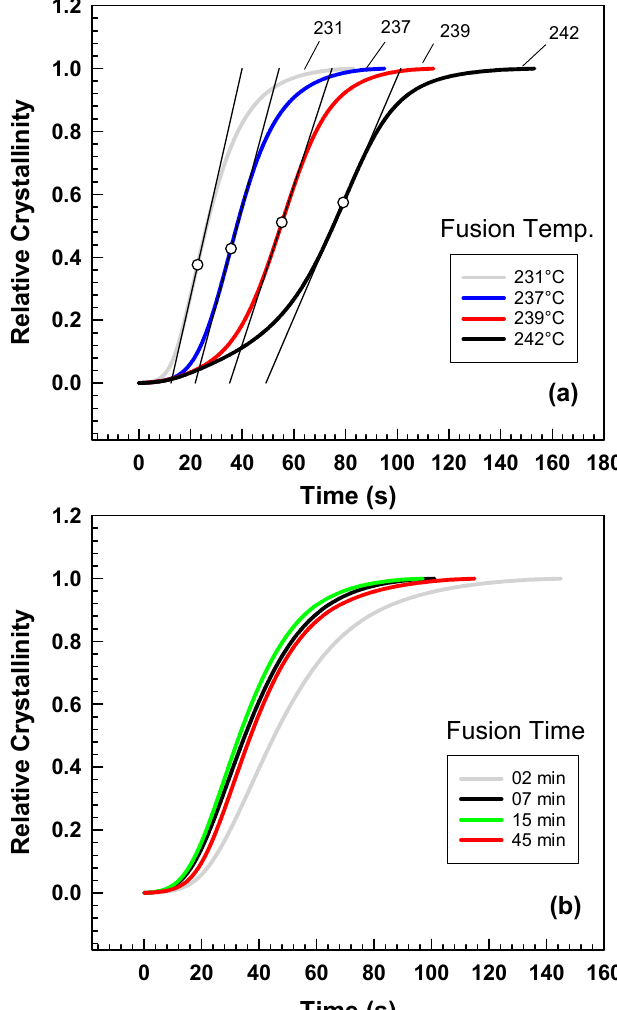
Figure 4. Crystallization kinetics from DSC relative crystallinity vs. time at different ( a ) fusion temperatures ( b ) fusion times.